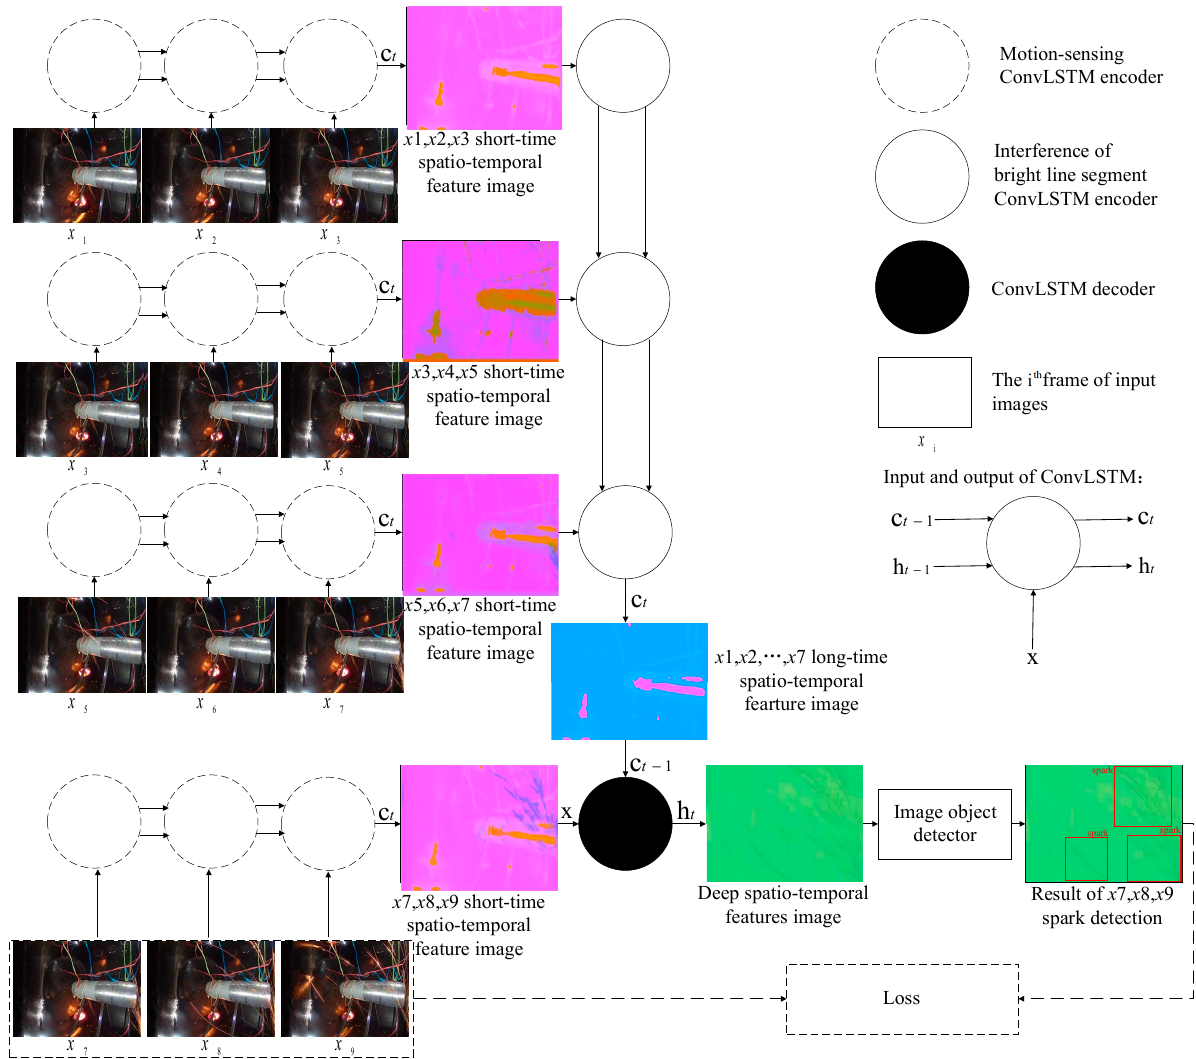
Figure 3. The information fusion-based spark detection model.